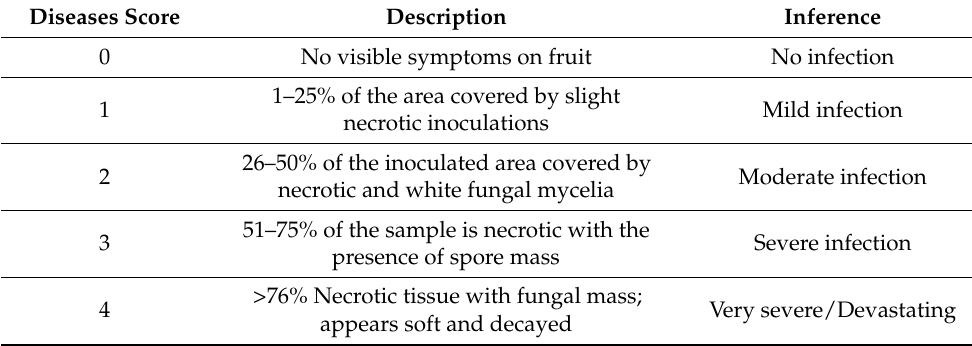
Table 1. Disease severity scores for disease assessment of tomato fruit. Diseases Score Description Inference 0 No visible symptoms on